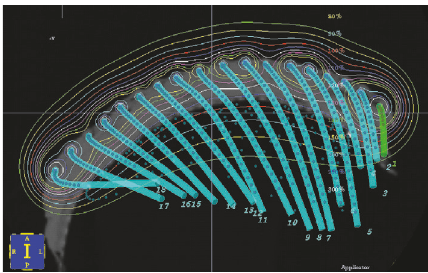
Figure5:Abrachytherapymouldwherethebrachytherapycontain- ers or tubes or wires are kept in a pattern by the mould, usually the wires are separated by equal spacing. There is usually some water-equivalent material called bolus or build-up (BU) between the brachytherapy tubes and the skin; this enables the dose cloud, by the time it gets to the skin, to have a homogeneous wave front. See the thin red